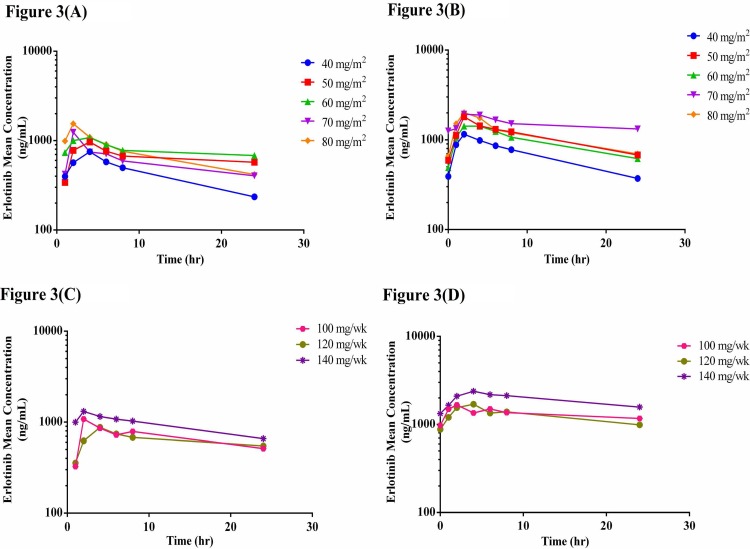
Mean plasma concentration-time curves of erlotinib (A) on Day 3 after initial oral dose with CSV dosing regimen of vinorelbine, (B) on Day 10 at the steady state after oral dose with CSV dosing regimen of vinorelbine, (C) on Day 3 after initial oral dose with MSV dosing regimen of vinorelbine and (D) on Day 10 at the steady state after oral dose with MSV dosing regimen of vinorelbine.